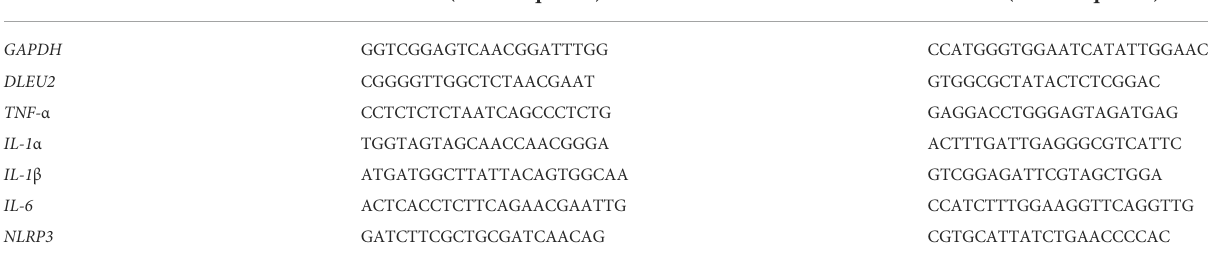
TABLE 1 Primers used in